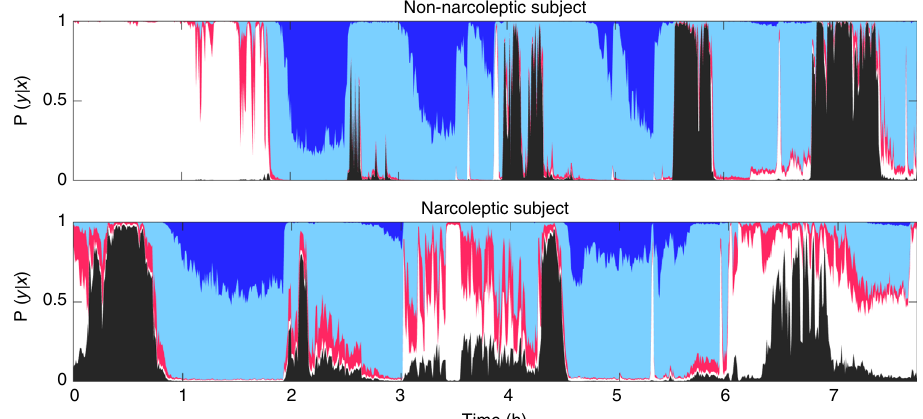
Fig. 3 Examples of hypnodensity graph in subjects with and without narcolepsy. Hypnodensity, i.e., probability distribution per stage of sleep for a subject without narcolepsy (top) and a subject with narcolepsy (Bottom). Color codes: white, wake; red, N1; light blue, N2; dark blue, N3; black, REM